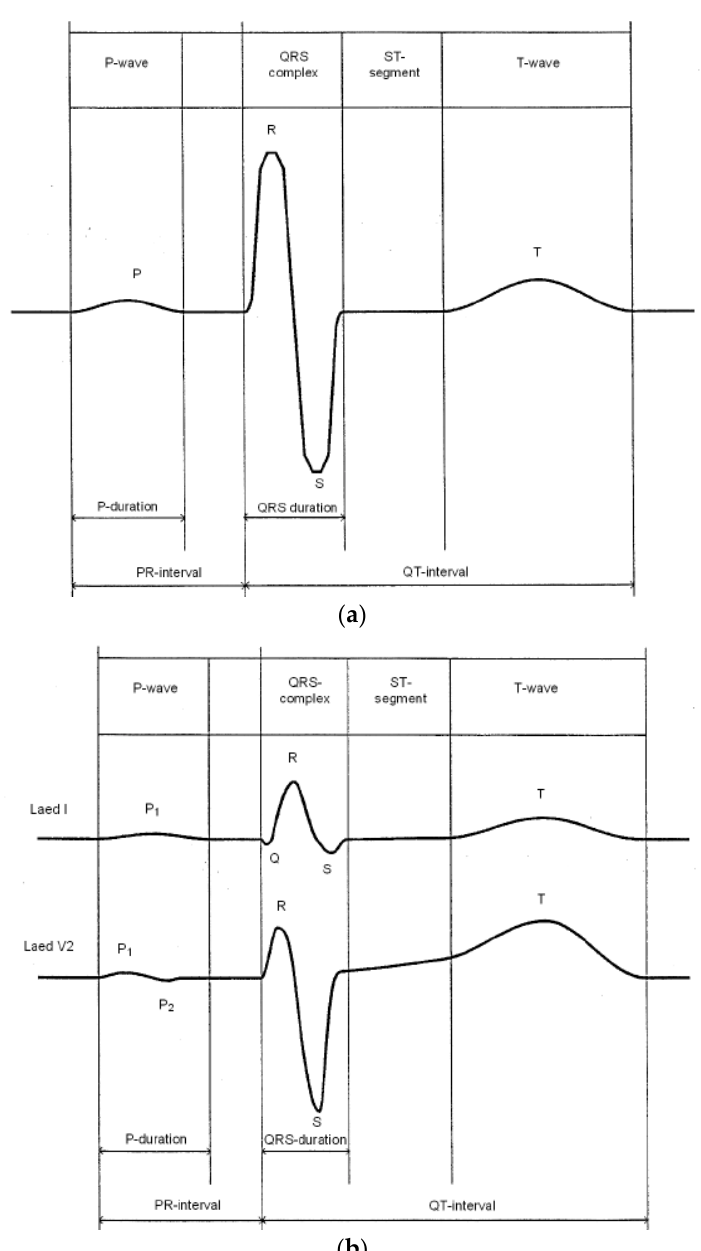
Figure 1. Examples of simulated waveforms from the CTS database used for algorithm performance testing in current ECG standards [2]. ( a ) Example of a calibration ECG waveform with ECG waves and interval nomenclature indicated; ( b ) example of an analytic ECG waveform with ECG waves and interval nomenclature indicated.